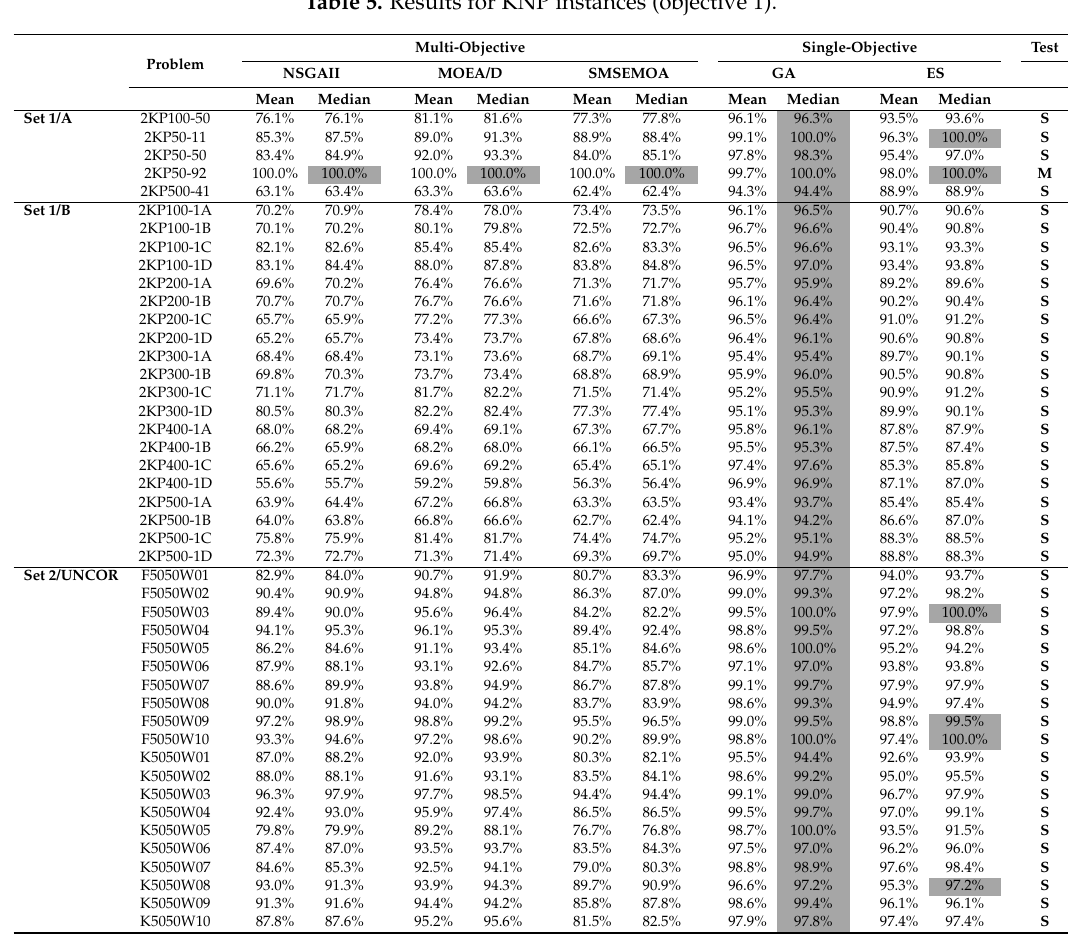
Table 5. Results for KNP instances (objective